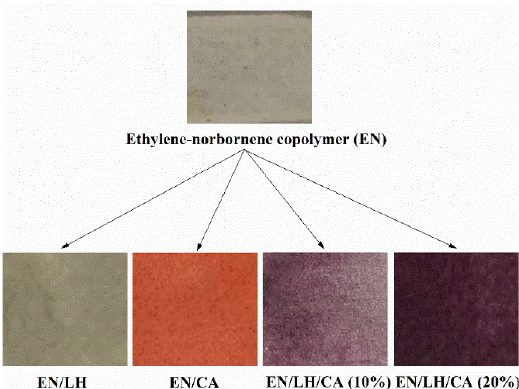
Figure 12. Digital photographs of ethylene-norbornene copolymer containing LH host, carminic acid, and hybrid pigments.